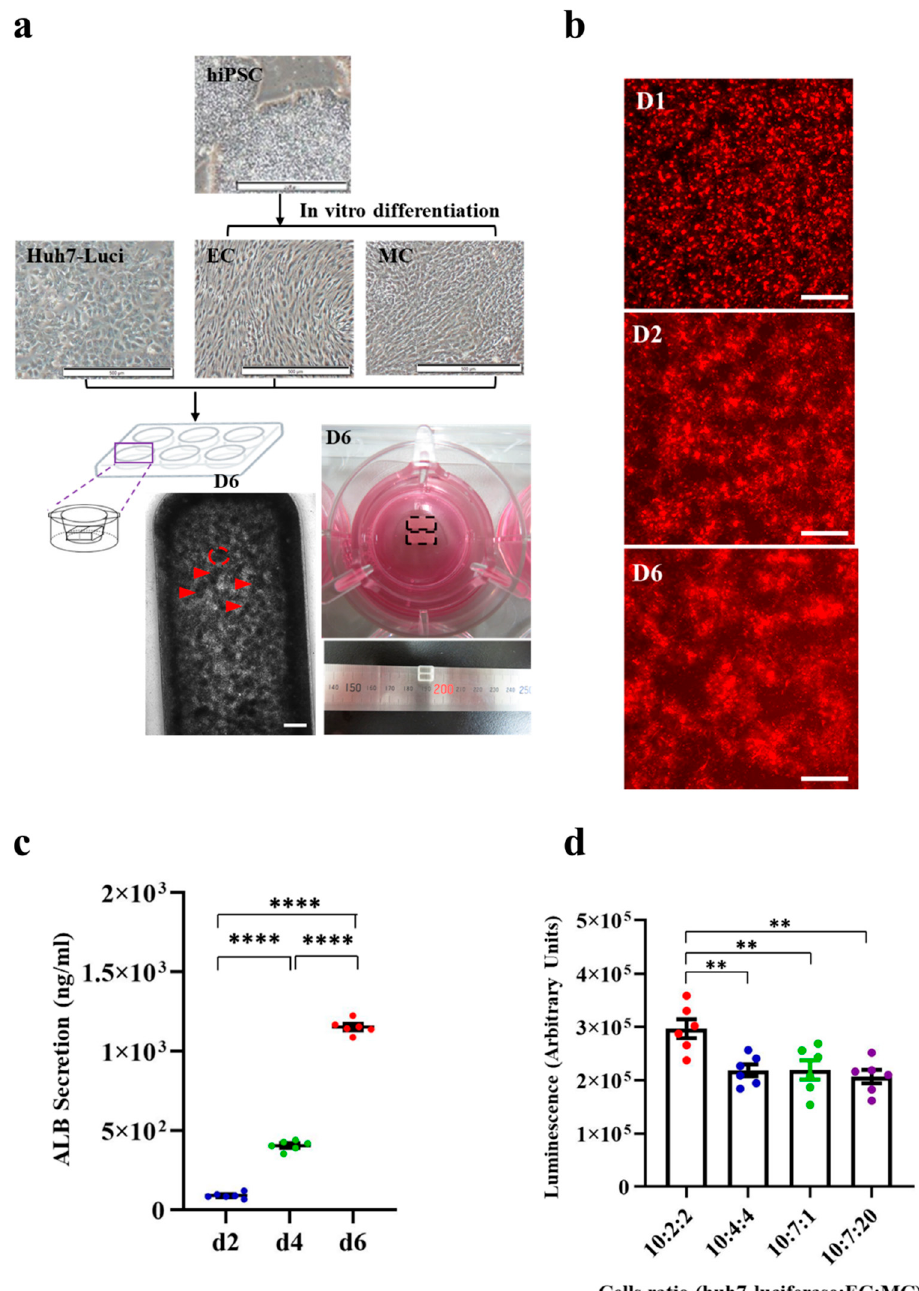
Figure 1. Generation of human hepatocellular carcinoma (HCC) organoid. ( a ) Bright-field image of the protocol for the generation of human HCC organoid. Morphology of human HCC organoid in the Ibidi culture-insert 2 well system at day 6. After 6 days of cultivation, the human HCC organoid was generated. Red arrows indicate single mini HCC organoid. The red dotted line indicates the area of each mini HCC organoid. The black dotted line indicates the rectangular tissue block. The scale bar represents 500 μ m. ( b ) Live imaging of KO-EC with Huh7-Luci and iPSC-MC in the Ibidi culture-insert 2 well system at day 1, 2, and 6. The scale bar represents 200 μ m. ( c ) ELISA of ALB secretion in HCC organoid at day 2, 4, and 6. One-way ANOVA followed by Tukey’s multiple comparisons test ( n = 6/group). ( d ) Luciferase measurement of Huh7-Luci in HCC organoids generated by different composition ratio of Huh7-Luci, iPSC-EC, and iPSC-MC. One-way ANOVA followed by Tukey’s multiple comparisons test ( n = 6/group). ** p < 0.01, **** p < 0.0001.